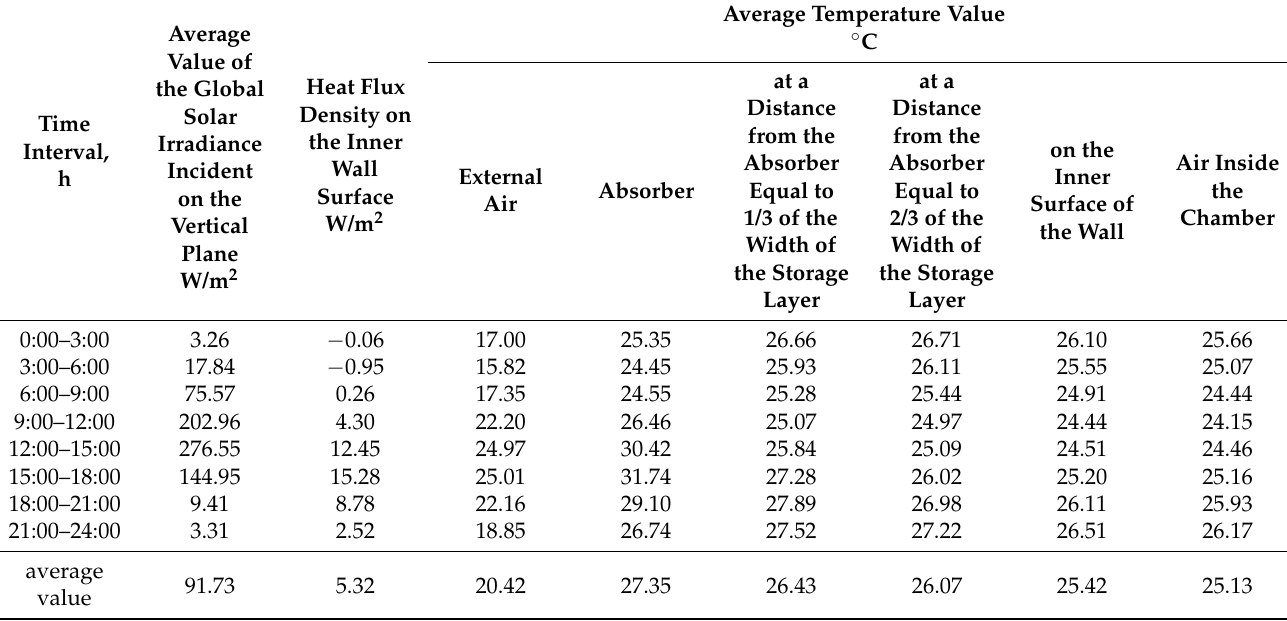
Table 3. Summary of the results of the tests carried out in